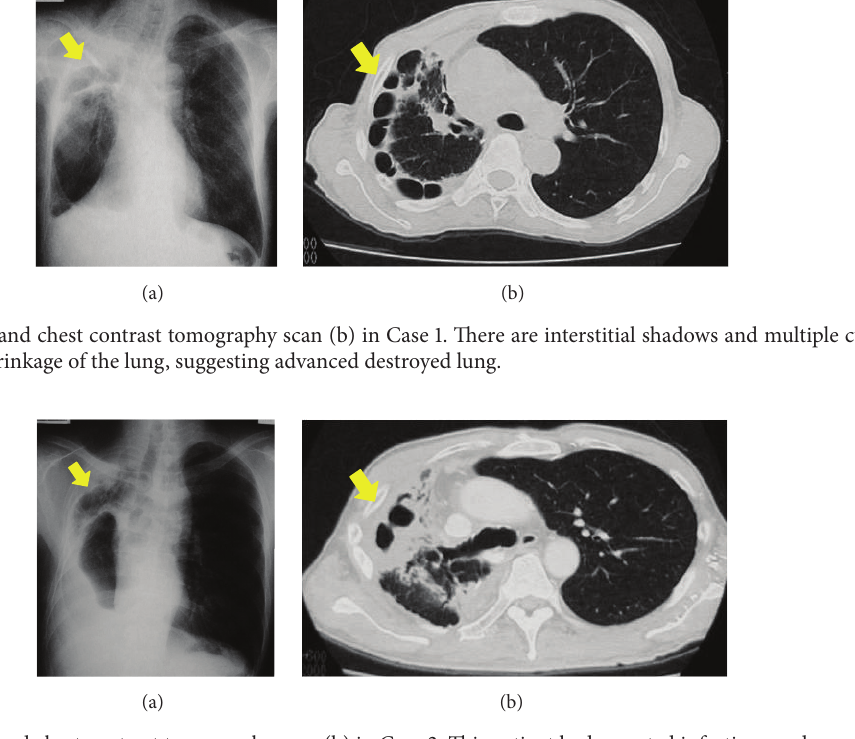
Figure 2: Chest X-ray (a) and chest contrast tomography scan (b) in Case 2. This patient had repeated infections and severe destroyed lung in which almost all the existing lung structures were